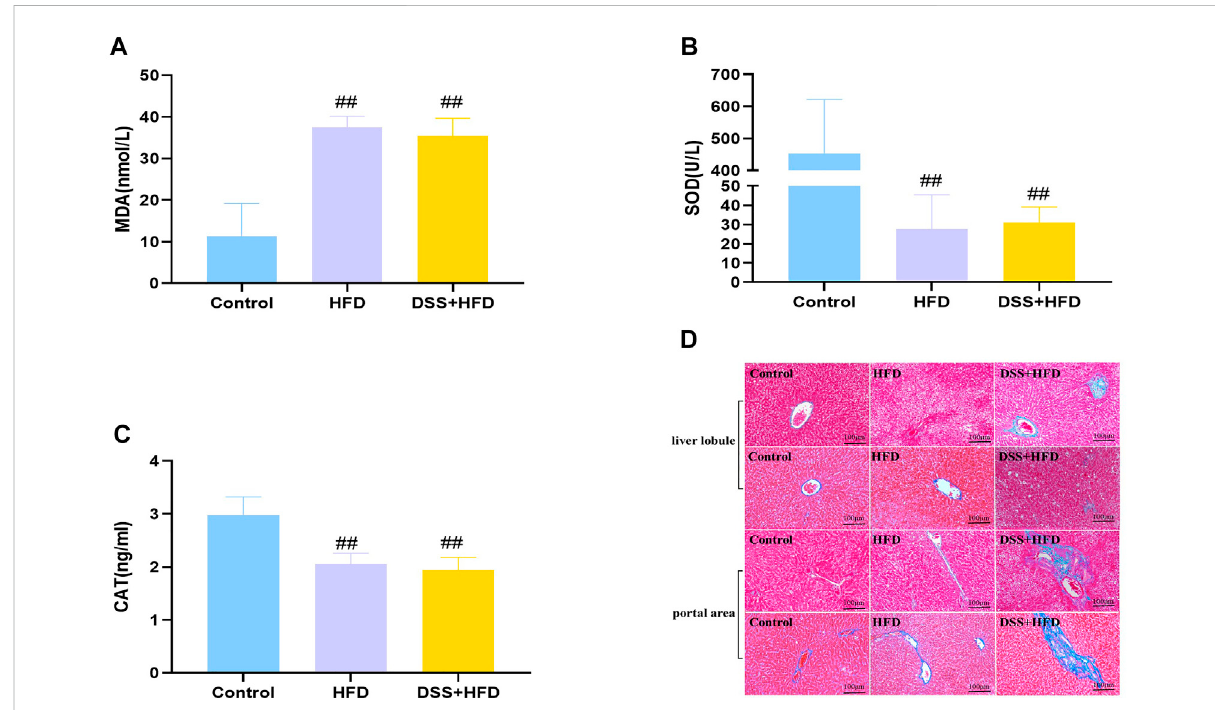
FIGURE 4 EffectofHFDandDSSinteractiononlevelsofoxidativestressand fi brosis. (A) MDAcontents. (B) SODactivity. (C) CATactivity. (D) Liversections in the three groups were stained with Masson staining. Regionsof blue staining representing collagen fi ber. Pictures were taken under a microscopy withobjectlensesof×10.Valuesarethemeans±SD( N =5).Control:standardchow;HFD:highfatdiet;DSS+HFD:highfatdiet+1%DSSindrinking water. # p < 0.05, ## p < 0.01, vs. the control